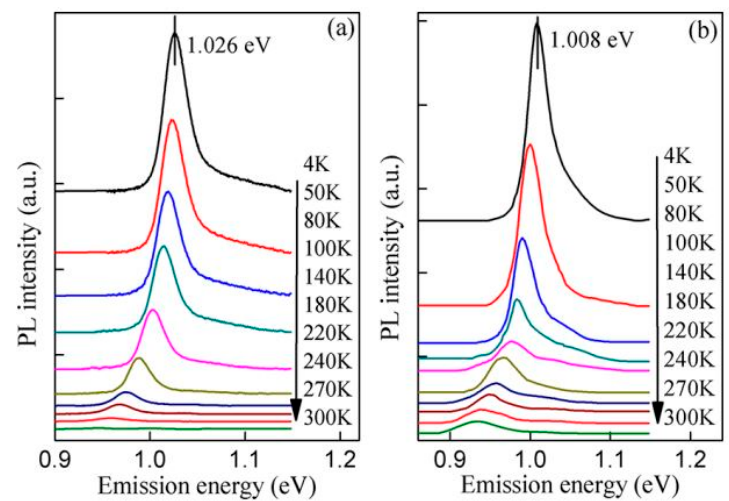
Figure 10. PL spectra measured at 4–300 K from ( a ) the QDU and ( b ) QDP laser structures. Repro- duced with permission from [78]. American Chemical Society, 2018.